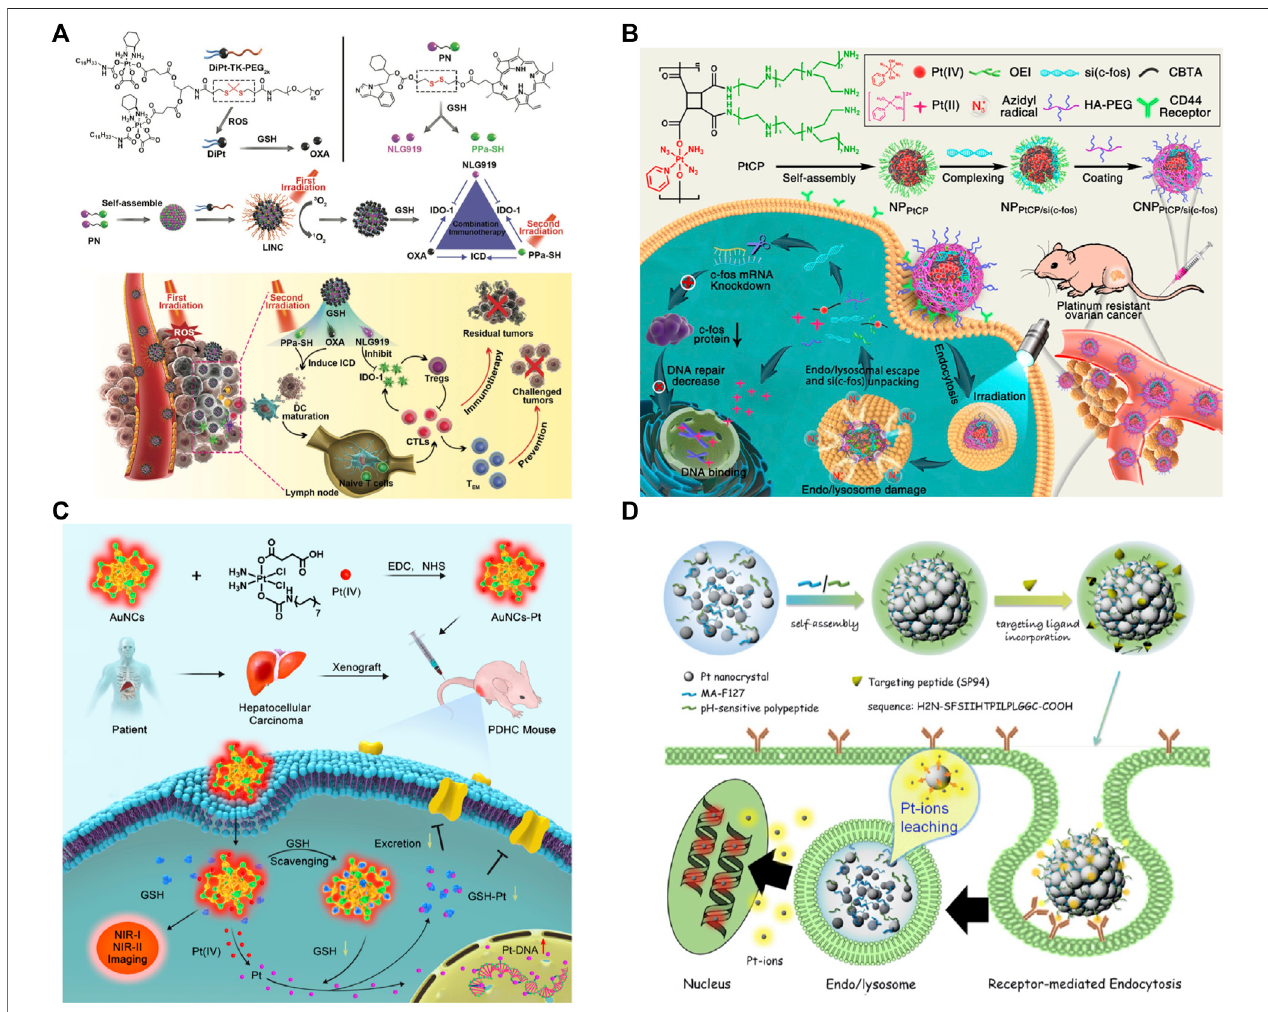
FIGURE 2 | Tumor-targeting Pt nanosystems. (A) PEGylated OXA prodrug (DiPt-TK-PEG 2K ). Reprinted with permission from Feng et al. (2019). Copyright 2019 WILEY-VCH Verlag GmbH & Co. KGaA, Weinheim. (B) Photoactivatable Pt prodrug-backboned nanosystem [CNP PtCP/si(c-fos)] for light-controlled